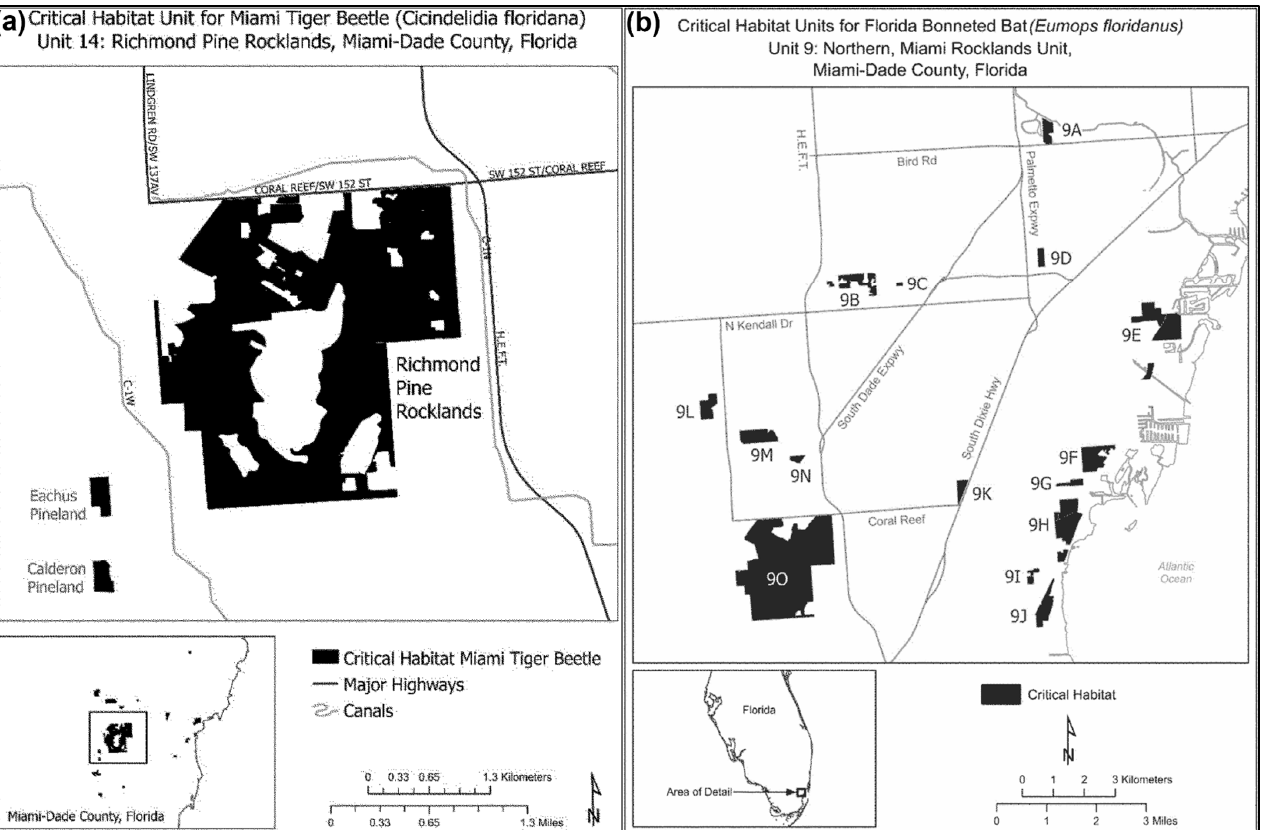
Figure 3. Miami tiger beetle and Florida bonneted bat proposed critical habitat. ( a ) Proposed critical habitat for the Miami tiger beetle at TRT and neighboring properties encompassing 589 ha of TRT. ( b ) Proposed critical habitat for the Florida bonneted bat at TRT and neighboring properties encompassing 713 ha of TRT (labeled as 9O). Panels ( a , b ) were aggregated from USFWS (2021) and USFWS (2022).